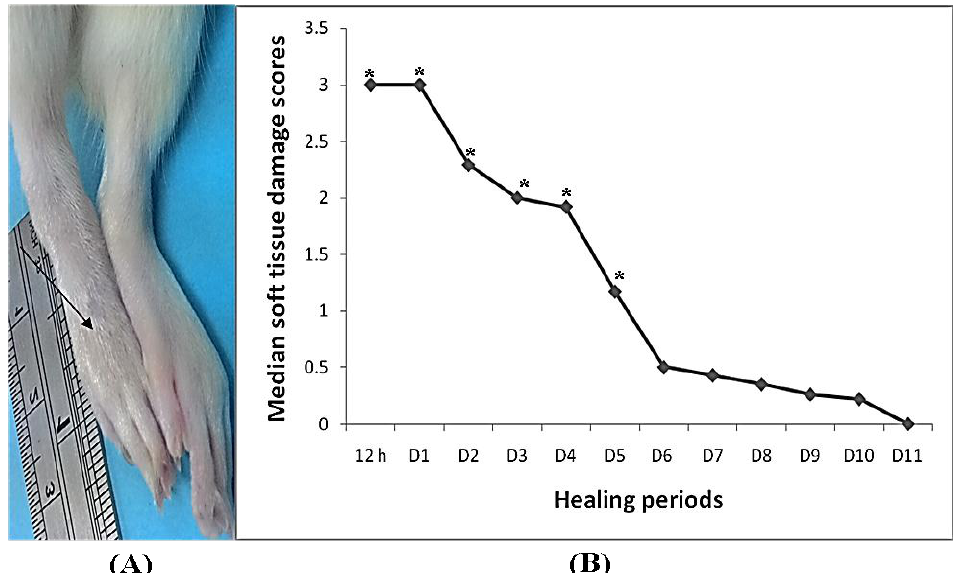
Figure 5. Photograph and graphical comparative appearance of surgical site at day 11 post surgery and graphical trend of soft tissue damage scores during healing. (A) Soft tissue injury comparison between fractured limb (indicated by arrow) and the counter lateral control limb at day eleven post operation when visible signs of soft tissue injury disappeared. (B) Trend of soft tissue damage from 12 hrs post operation to its disappearance. *Denotes significant differences ( P <0.05; nonparametric Kruskal-Wallis one-way ANOVA) from D10 among degree of soft tissue damage at different healing